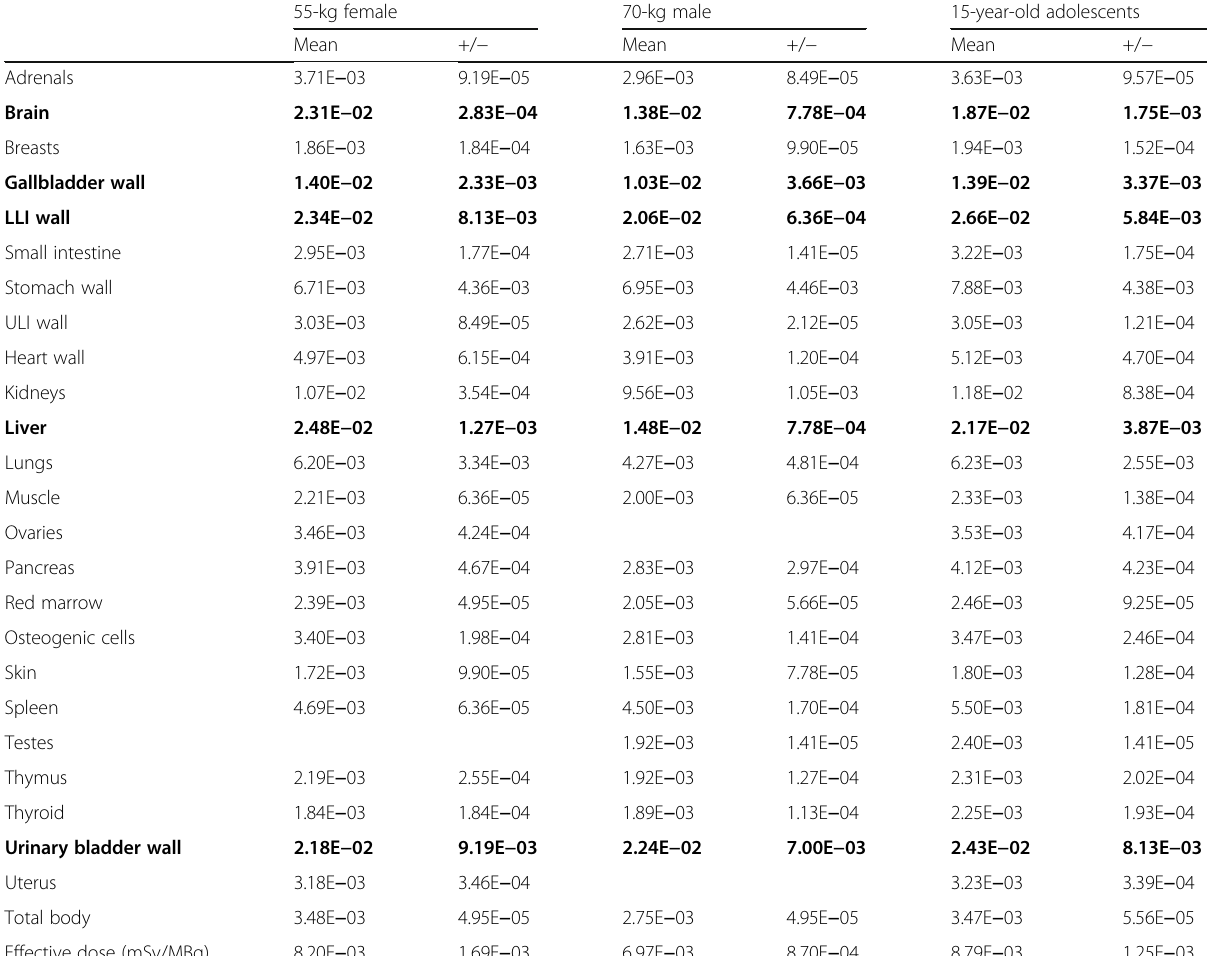
Table 4 Mean organ radiation doses (mSv/MBq). Adult male and female values were based on the residence times measured in males and females, respectively ( n = 2, each). For the adolescent calculation, the 4 residence time values were used, with the exception of reproductive